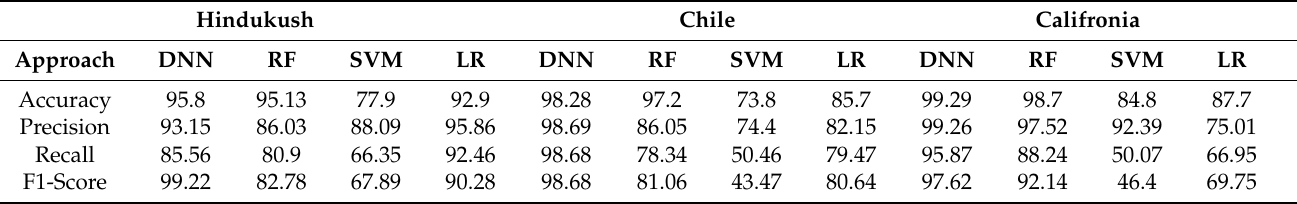
Table 4. Overall In-Sample Results of All Approaches from the Considered